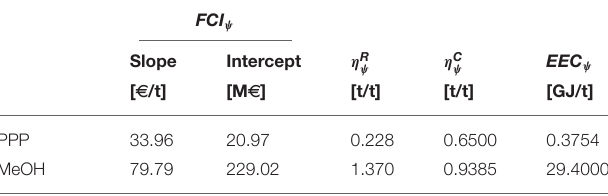
TABLE 3 | Arrays of slopes FCI slope